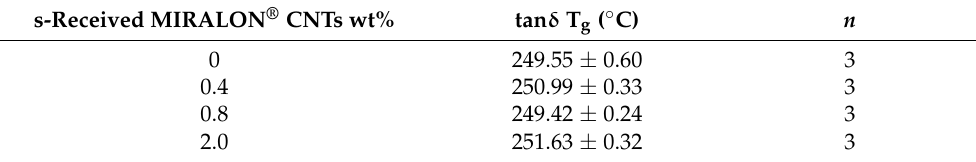
Table 3. Glass transition temperatures (T g ) ( µ ± δ ) as determined by DMA Q800 instrument